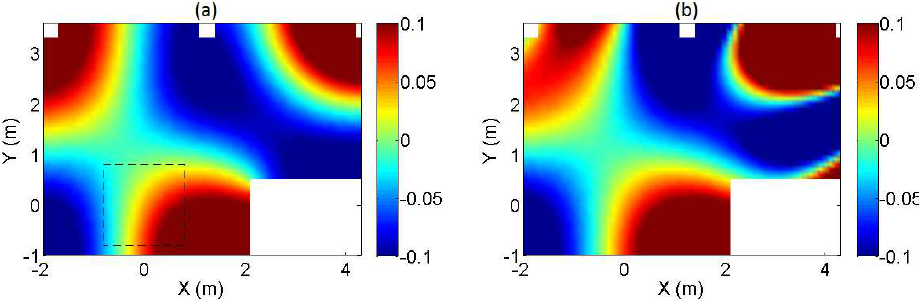
Figure 4. Target ( a ) and reconstructed ( b ) field of the reference room, 63 Hz.